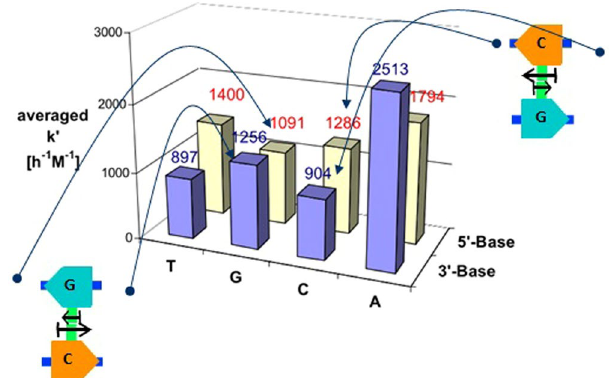
Figure 10. The bar plot from 13 , reproduced here with permission from PNAS, shows the experimentally observed dependence of rate of extension of a template-attached primer by a single nucleotide on its neighboring nucleotides. The rate of extension is higher when the nucleotide G is the immediate neighbor on the 3 ′ side of the primer, or when C is the 5 ′ side immediate neighbor on the downstream binding nucleotide. With G at the 5 ′ side and C at the 3 ′ side, the rates are lower. In other words, the base-pair 5 ′ – C –3 ′ /3 ′ – G –5 ′ supports higher rate of nuceotide incorporation to its left compared to 5 ′ – G –3 ′ /3 ′ – C –5 ′ , whereas 5 ′ – G – 3 ′ /3 ′ – C –5 ′ supports higher incorporation rate to its right compared to 5 ′ – C –3 ′ /3 ′ – G –5 ′ . This experimental observation strongly supports our view that the orientation of the base-pair dictates the direction of asymmetric cooperativity. The mode of asymmetric cooperativity also agrees with the direction of catalysis and stabilization derived from the relationship between replication directionality and GC skew sign. The asymmetric cooperativity also seems to exist in AT base-pair, but with an added constant component when the nucleotide A is present on the replica strand neighborhood. This figure is excluded from CC BY license that applies to the rest of the article and requires permission from PNAS to